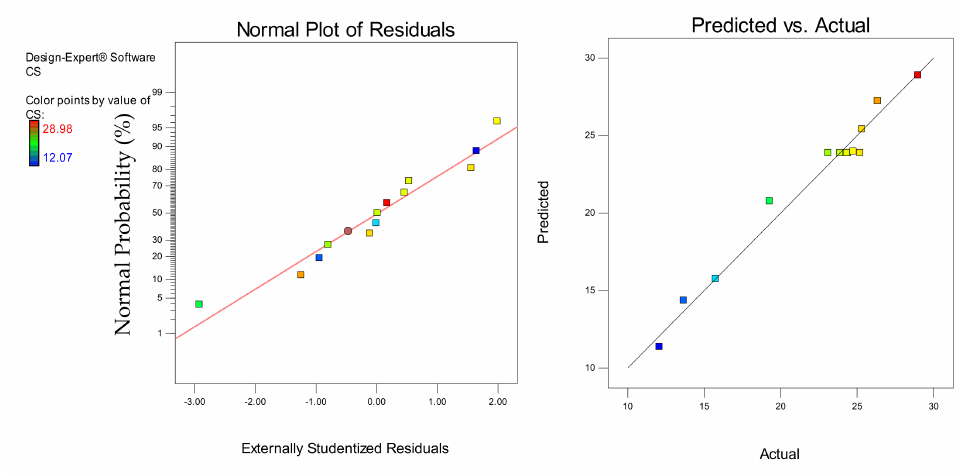
Figure 16. Normal plot of residuals and predicted vs. actual plots for the